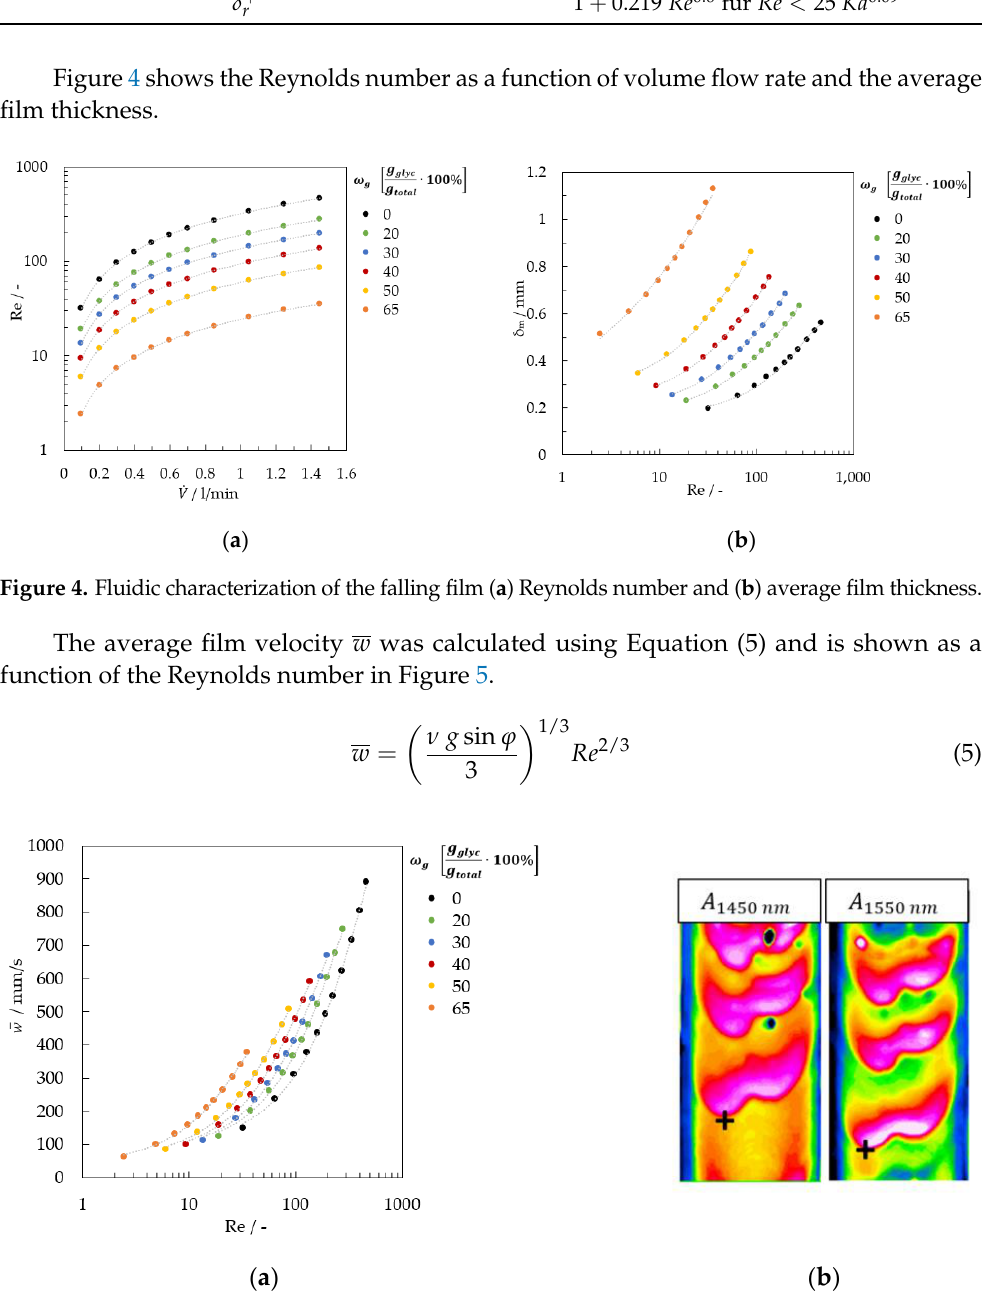
Figure 5. ( a ) Average film velocity and image shift in mm for image acquisition ( b ) example of image shift after 25 ms between 1450 and 1550 nm